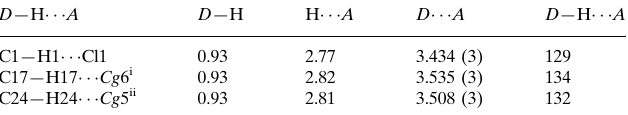
Hydrogen-bond geometry (A˚ , (cid:2)